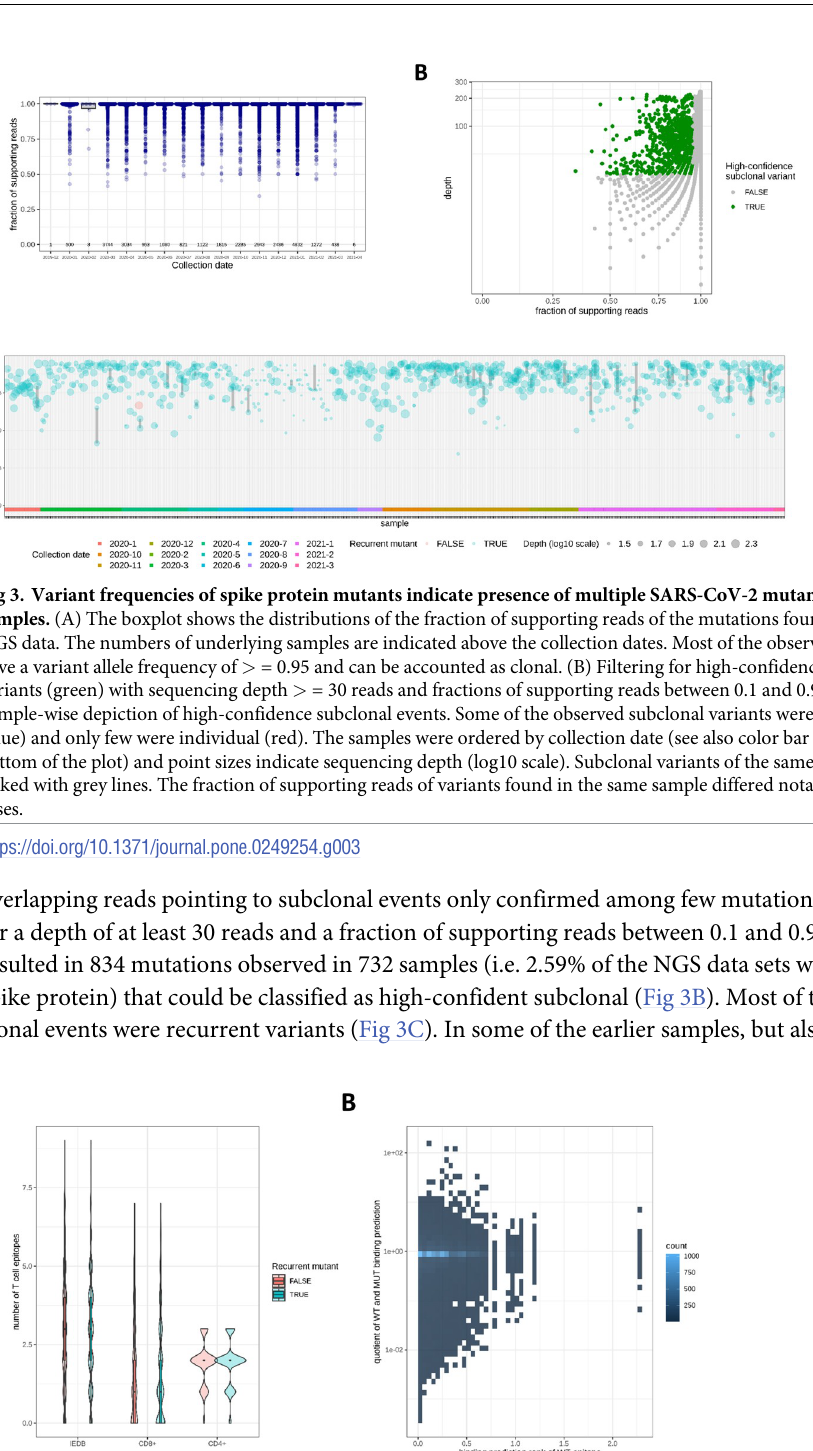
Fig 4. Variants affect antibody and T cell target sites. (A) The number of published T cell epitopes (listed in the IEDB or recognized by CD8+ or CD4+ T cells as reported by Snyder et al . [25] that are affected by recurrent or individual spike protein variants is depicted. Most of the variants hit at least one epitope. (B) Predicted binding affinity rank of wild type epitope (WT) vs. the quotient of the predicted rank of wild type and mutant epitope (MUT) depicted as heat map. Lower ranks indicate better binding. A small quotient indicates worse binding prediction for the mutant epitope.